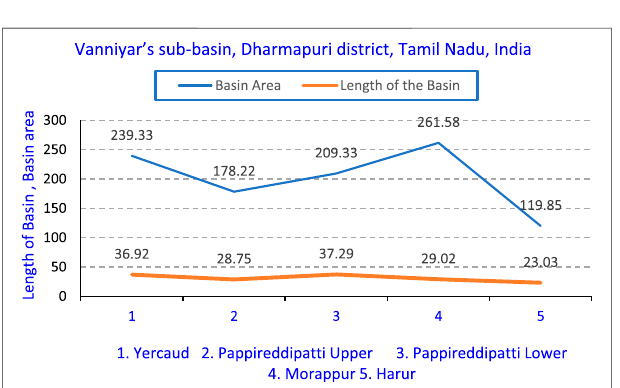
FIGURE 13 | Log – log plot of the basin area, A vs. stream length, Lu.